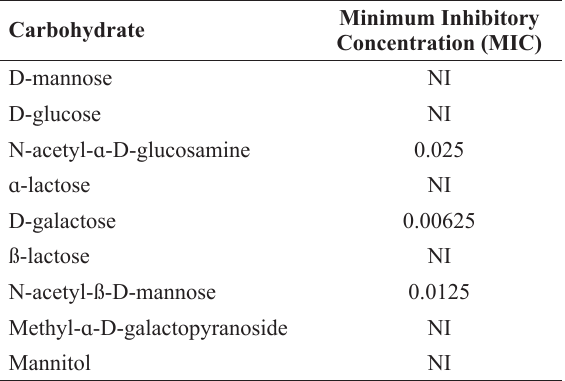
Inhibitory effect of sugars on the hemagglutinating assay of Spirogyra spp. total extract.